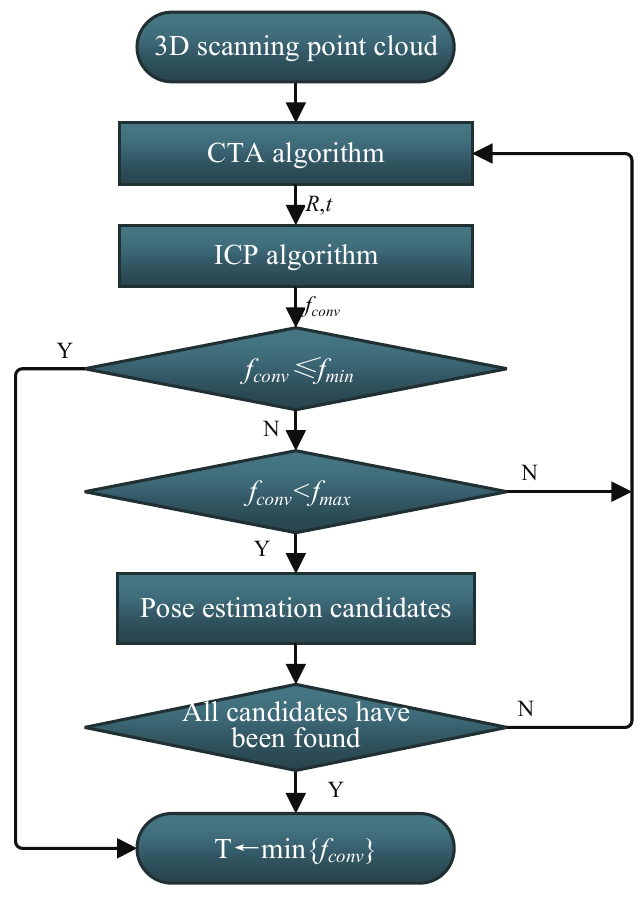
Figure 5. Logic of successful pose estimation for the CTA